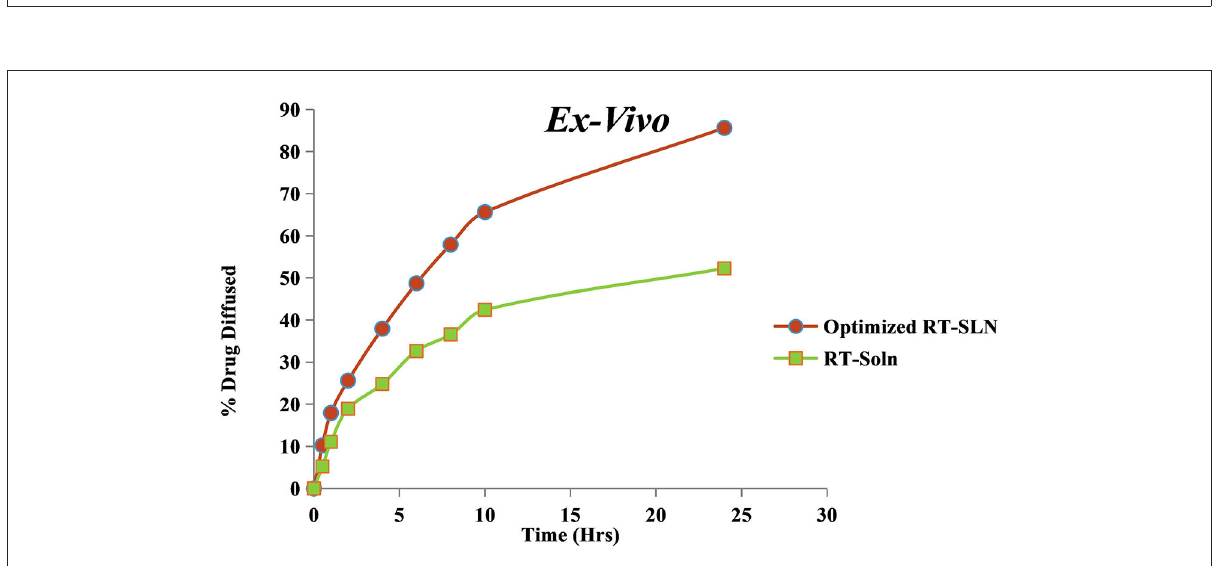
FIGURE9 Ex vivo study of optimized